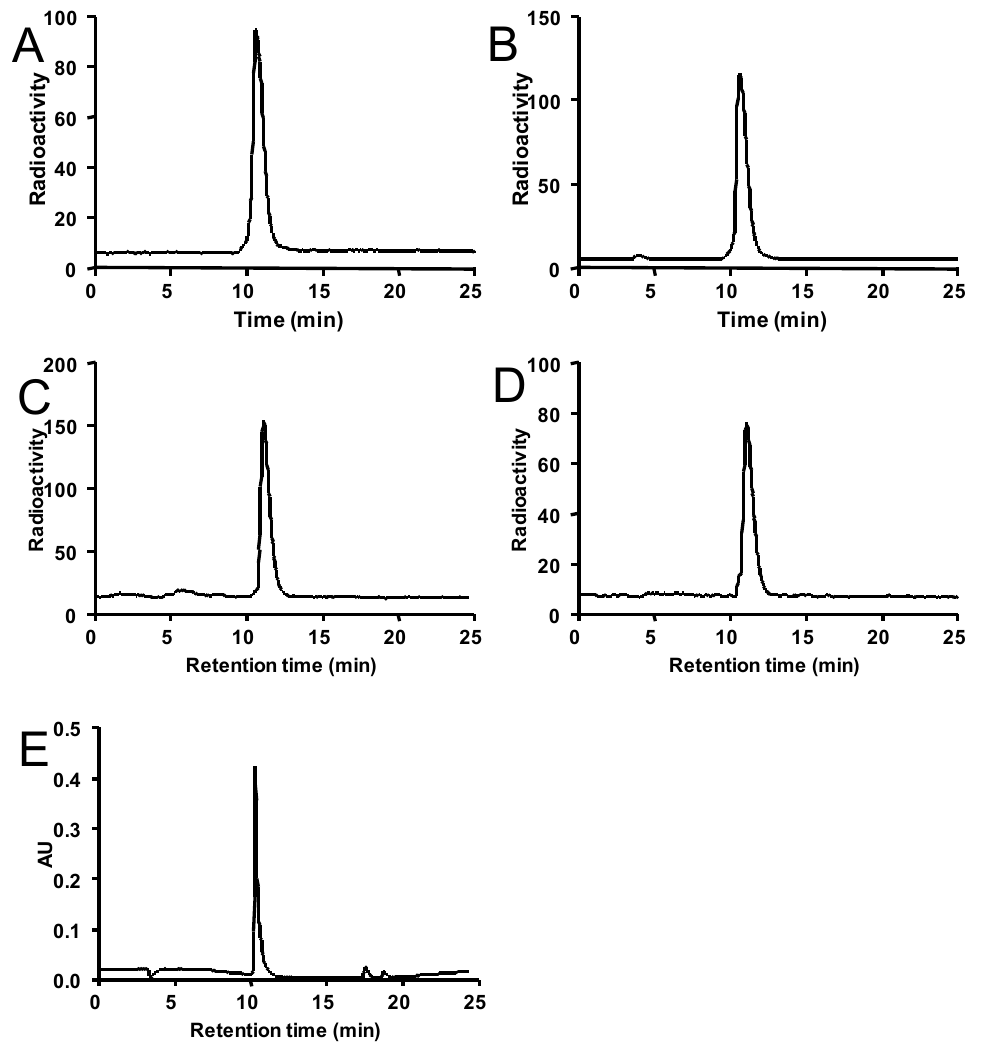
Figure 1. In vitro stability. ( A ) The radiotrace standard of 64 Cu-Ba Sar after 20 h incubation in 1 × PBS. ( C ) The radiotrace of 64 Cu-Ba of 64 Cu-Ba 3 3 h incubation in mouse serum. ( D ) The radiotrace of 64 Cu-Ba mouse serum. ( E ) The UV trace of standard 64 Cu-Ba